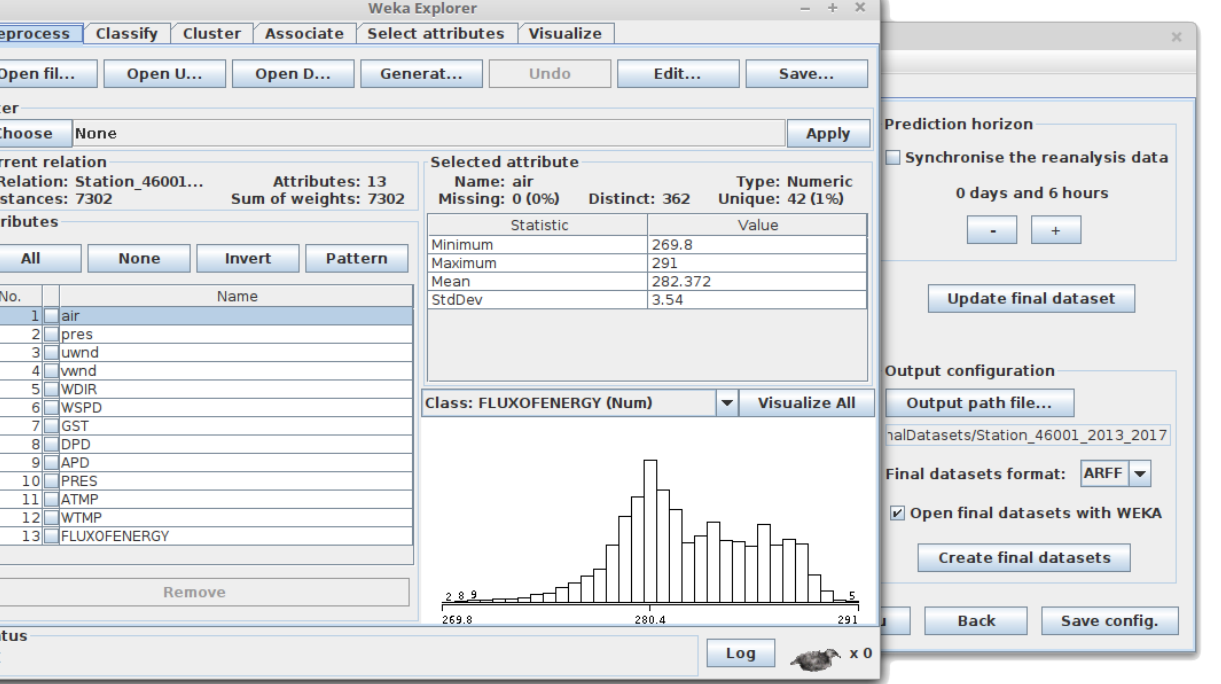
Figure 24. Final dataset opened with the environment Explorer of WEKA (energy flux